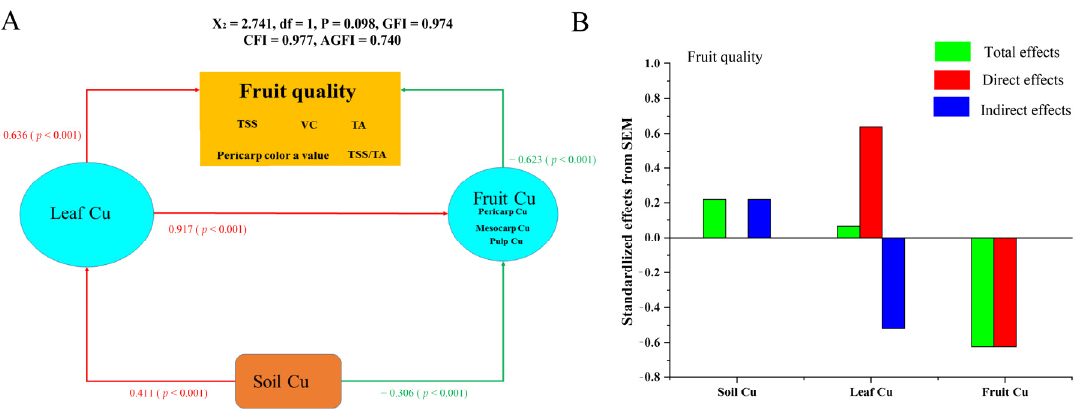
Figure 5. Linear regression analysis of soil-plant Cu concentrations versus different fruit qualities of citrus (n = 51). ( A ) Soil Cu versus pericarp color a value, ( B ) soil Cu versus Vc, ( C ) leaf Cu versus TSS/TA, ( D ) leaf Cu versus Vc, ( E ) pericarp Cu versus TSS, ( F ) mesocarp Cu versus pericarp color a value, ( G ) mesocarp Cu versus TSS, ( H ) pulp Cu versus pericarp color a value, ( I ) pulp Cu versus TSS. * and ** superscripts after R 2 values indicate statistical differences at p < 0.05 and p < 0.01, respectively.